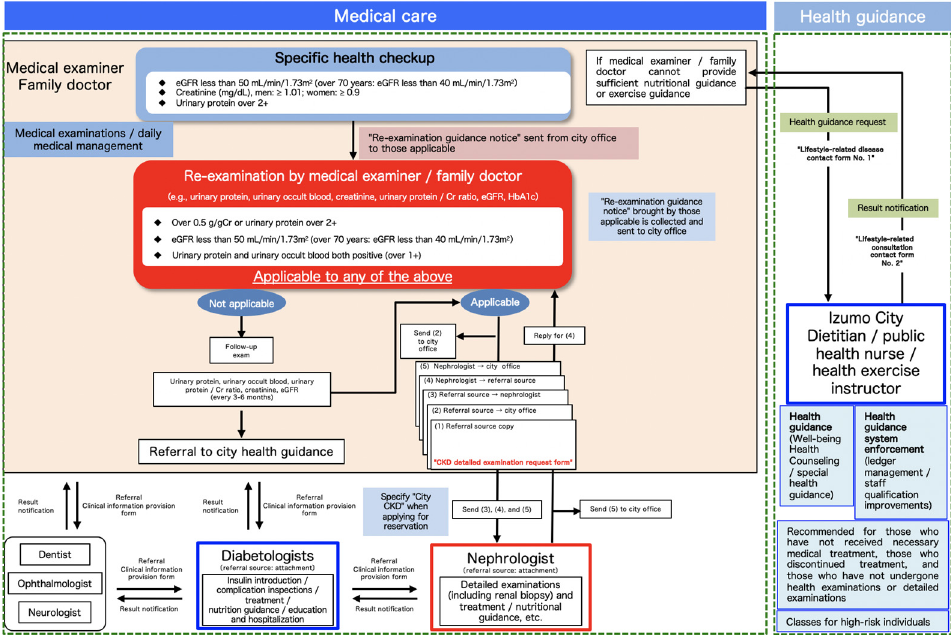
Figure 1. Izumo City CKD Exacerbation Prevention Countermeasures flow chart showing specific health checkup and family doctor CKD determination criteria. The flow chart shows subsequent referrals to nephrologists/diabetes specialists, dentists, ophthalmologists, neurologists, or well-being health counseling (health guidance). CKD, chronic kidney disease; Cr, creatinine; and eGFR, estimated glomerular filtration rate.